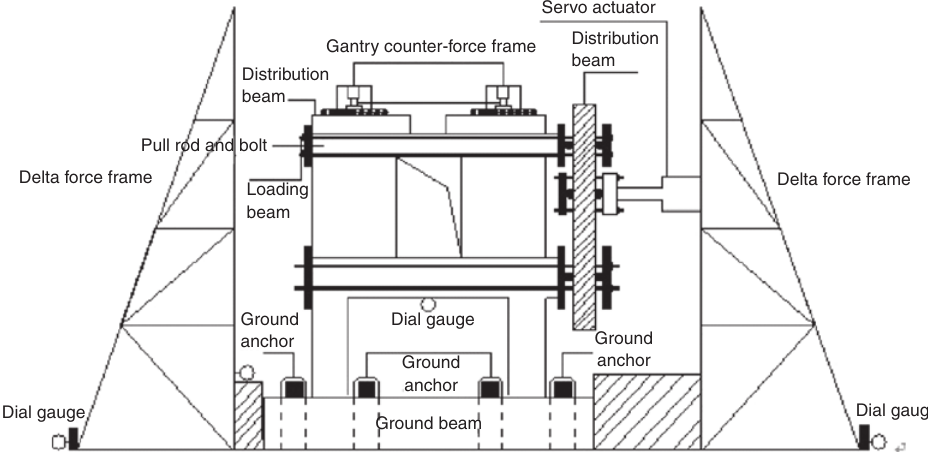
Figure 2: Loading equipment.